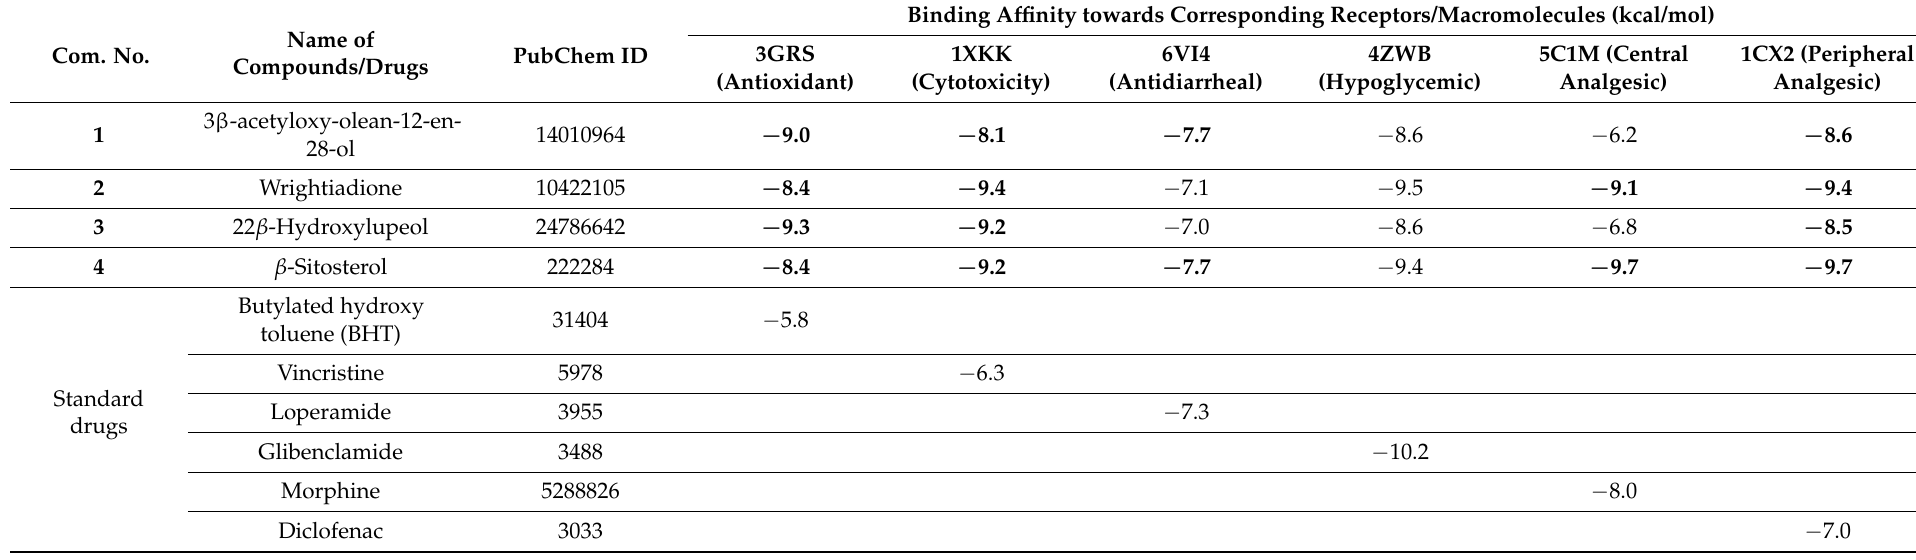
Table 6. Molecular docking scores or binding affinity (kcal/mol) retrieved from in silico interactions of the isolated compounds from W. coccinea (Roxb. ex Hornem.) Sims and the standard drugs during the interaction with glutathione reductase (PDB ID: 3GRS), epidermal growth factor receptor (PDB ID: 1XKK), kappa